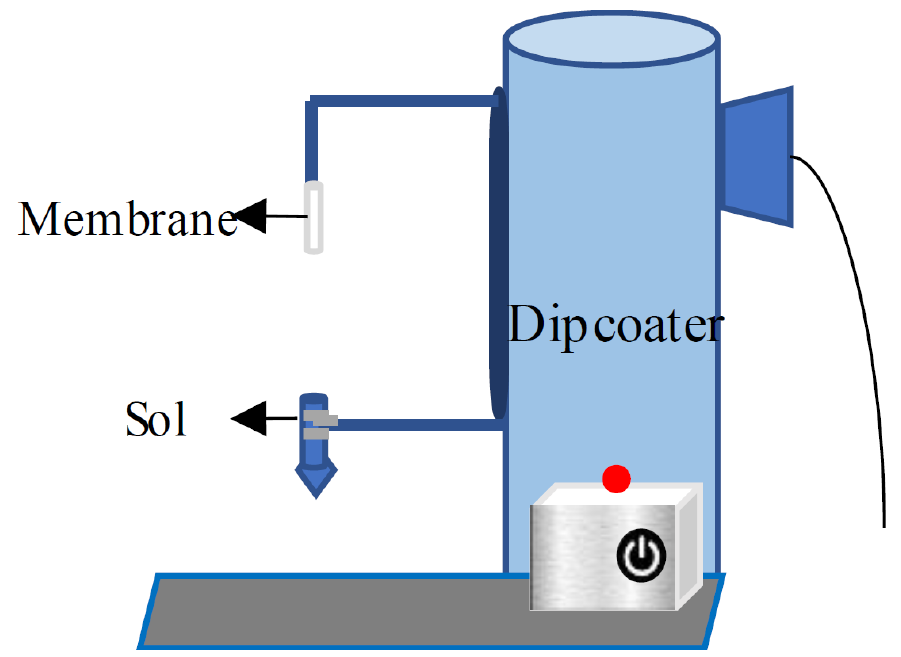
Figure 1. Dipcoater setup of silica thin film